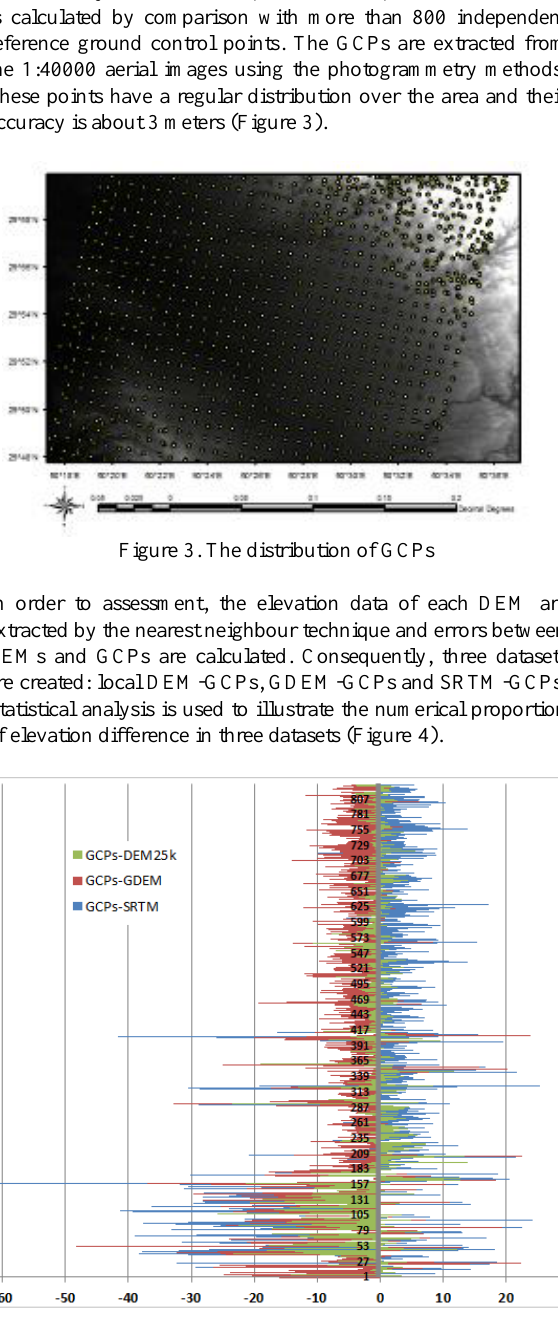
Figure 4. Statistical graphs for Local DEM-GCPs (green), GDEM-GCPs (red) and SRTM-GCPs